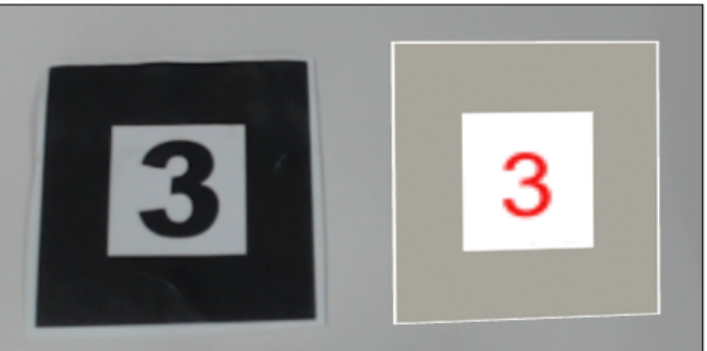
Figure 1. In the augmented reality (AR) scene, there is a physical number 3 marker ( left ) and a virtual number 3 marker ( right ). The border of the virtual marker is adjusted to